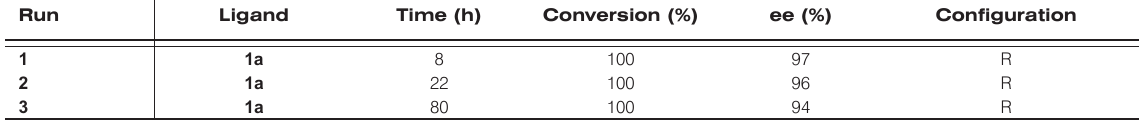
Table 2. Catalyst recycling in asymmetric transfer hydrogenation of acetophenone in [bmim][PF